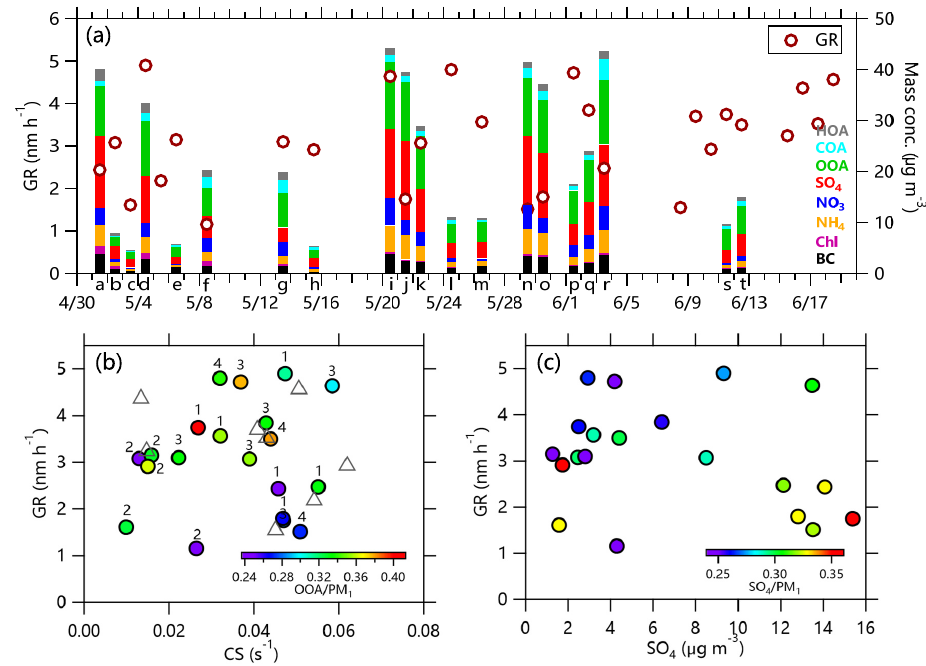
Figure 10. (a) Particle growth rates (GRs) and the corresponding aerosol composition during the growth period, (b) the relationship be- tween GR and CS, color-coded by OOA/PM 1 , and (c) the relationship between GR and sulfate concentration, color-coded by SO 4 / PM 1 . The numbers over the circles in (b) represent different source regions (Fig. 11) and the triangles represent data without information about